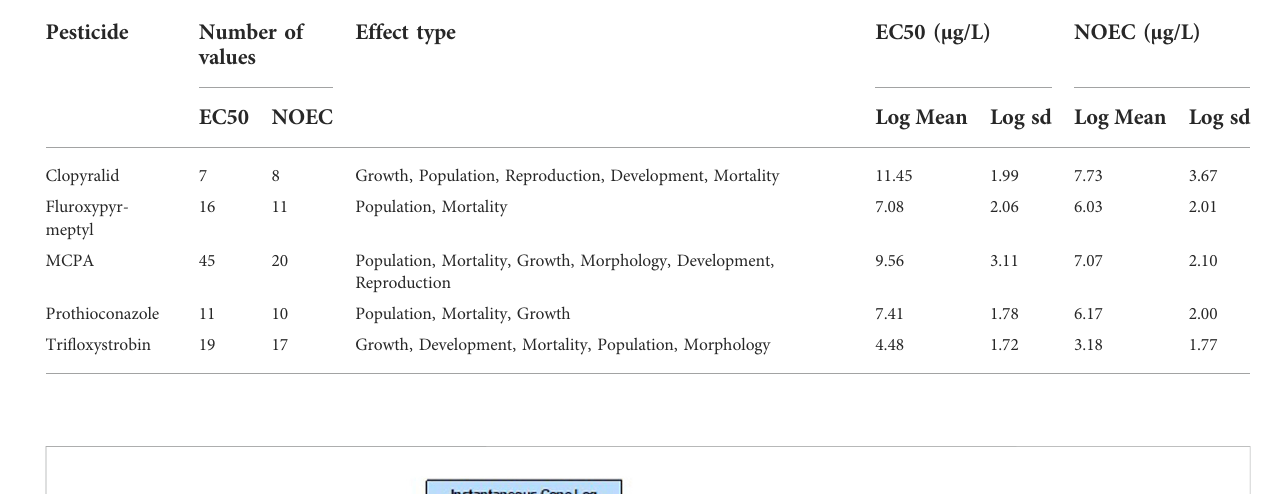
Frontiers in Environmental